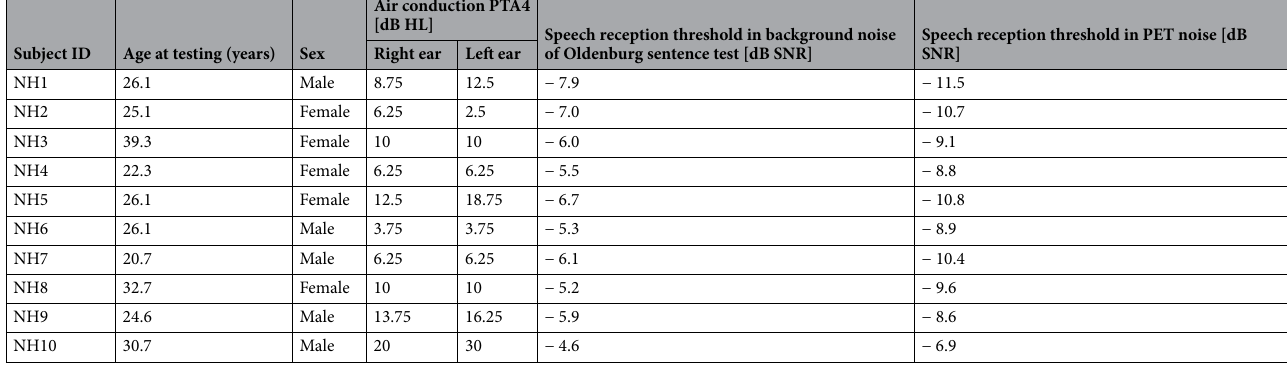
Table 1. Characteristics of included